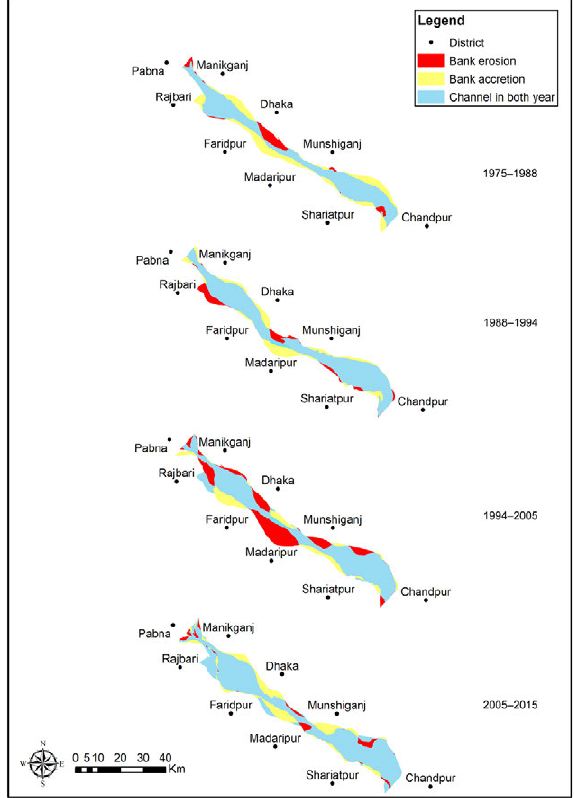
Fig. 2. Riverbank erosion-accretion along the Padma river for four